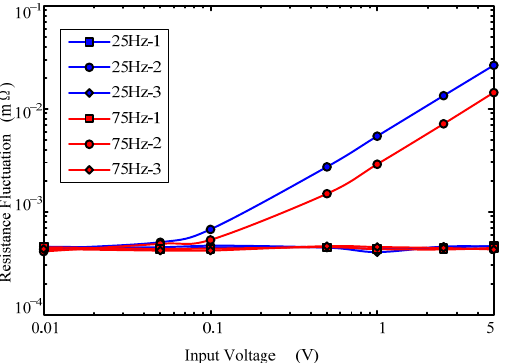
Figure 11. Contact resistance fluctuation variations with angular vibration